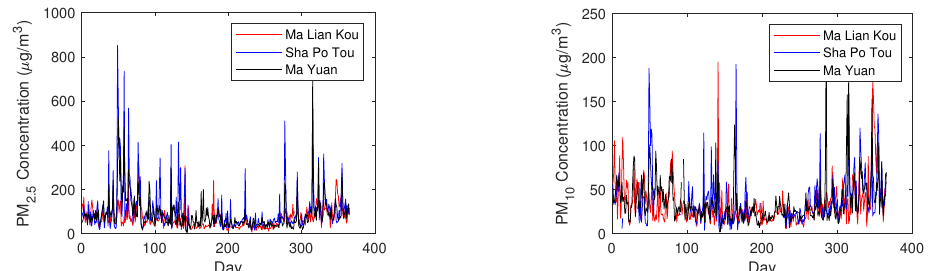
Figure 5. The variations of the concentrations for PM 2.5 and PM 10 at Ma Lian Kou, Sha Po Tou and Ma Yuan in